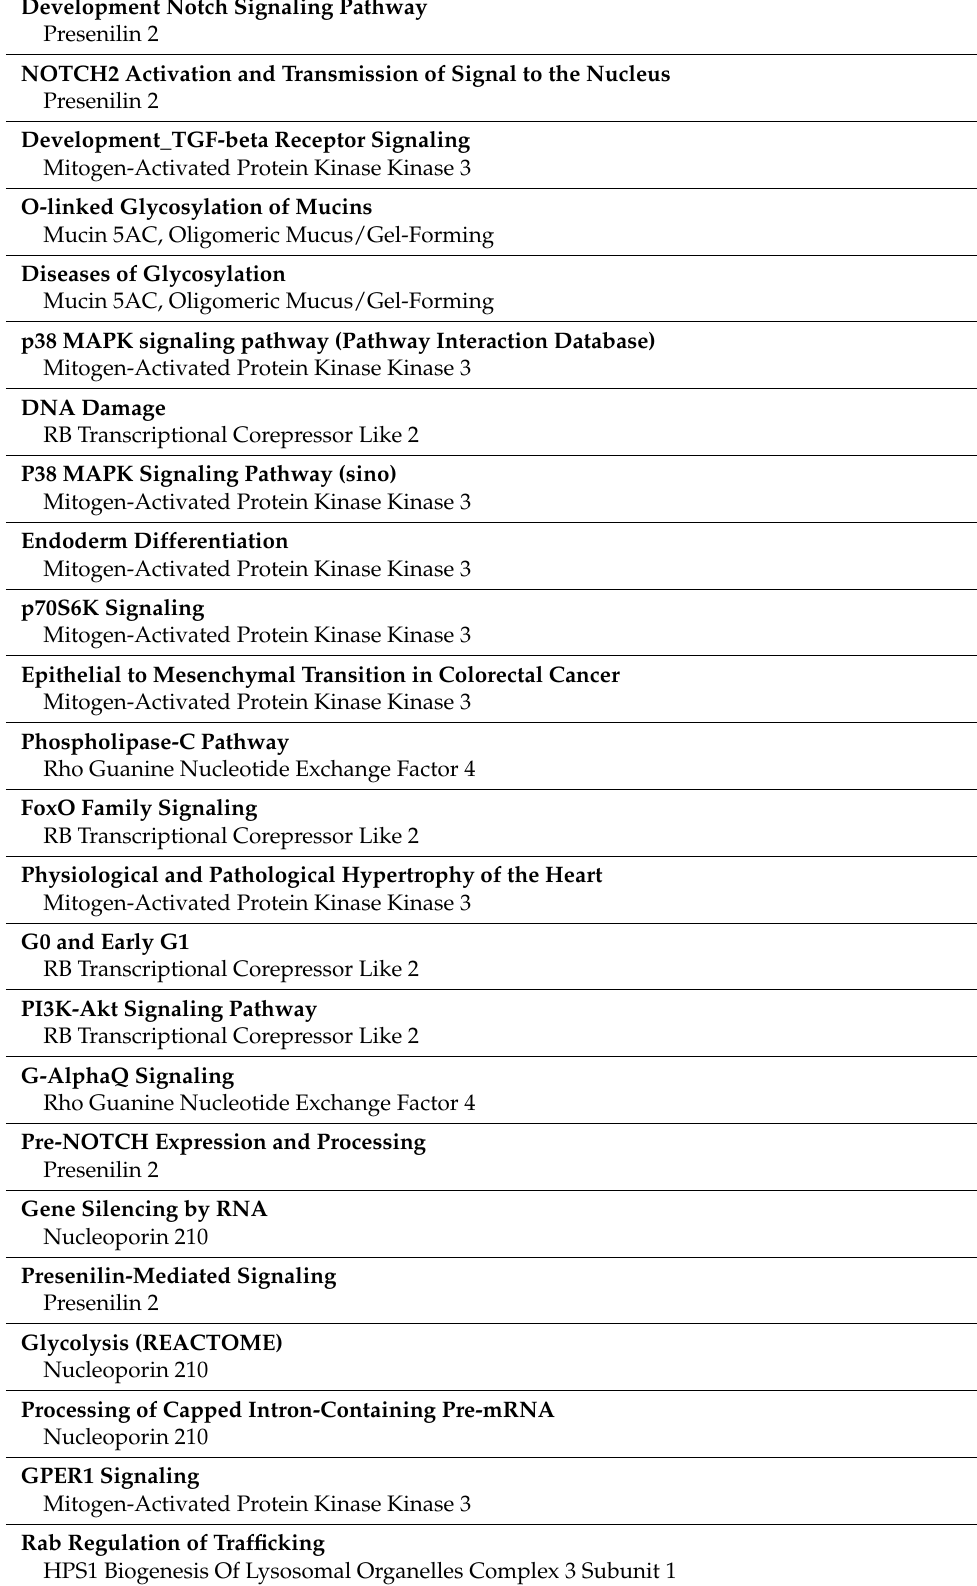
Table A2. Cont. Development Notch Signaling Pathway Presenilin 2 NOTCH2 Activation and Transmission of Signal to the Nucleus Presenilin 2